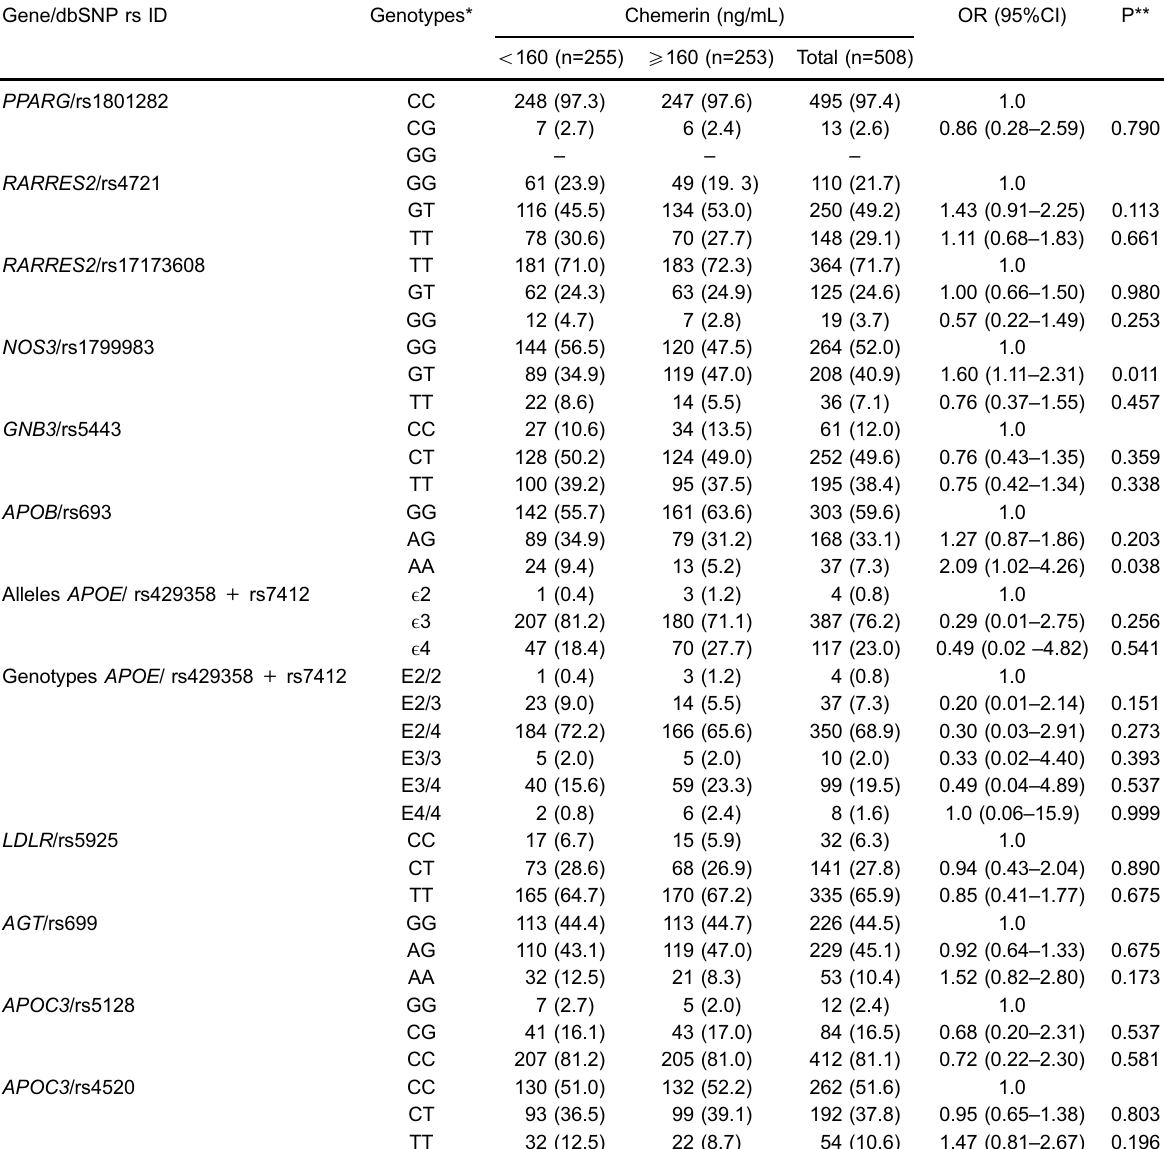
Table 4. Frequency of genotypes of a panel of 12 single nucleotide polymorphisms (SNP)-like polymorphisms in the study population by quartiles of